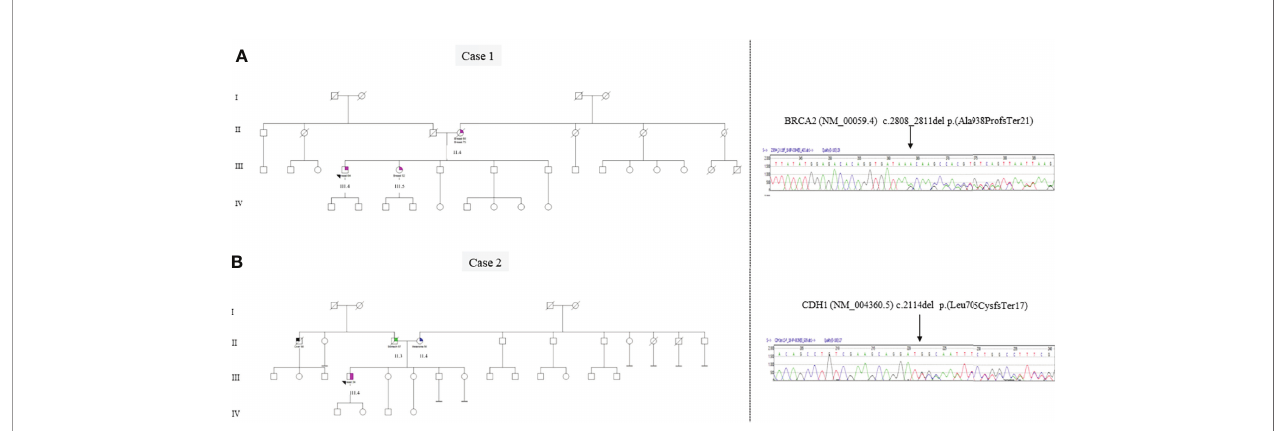
FIGURE 2 | Panel A : Genetic pedigree of case 1 and Sanger sequencing electropherogram of the BRCA2 exon 11 variant c.2808_2811delACAA (p.Ala938ProfsTer21). The alignment to the reference sequence of BRCA2 NM_000059.3 was created by the Mutation Surveyor ® Software (v5.1.0). Panel B : Genetic pedigree of case 2 and Sanger sequencing electropherogram of the CDH1 exon 13 variant c.2114delT (p.Leu705CysfsTer17). The alignment to the reference sequence of CDH1 NM_004360.3 was created by the Mutation Surveyor ® Software